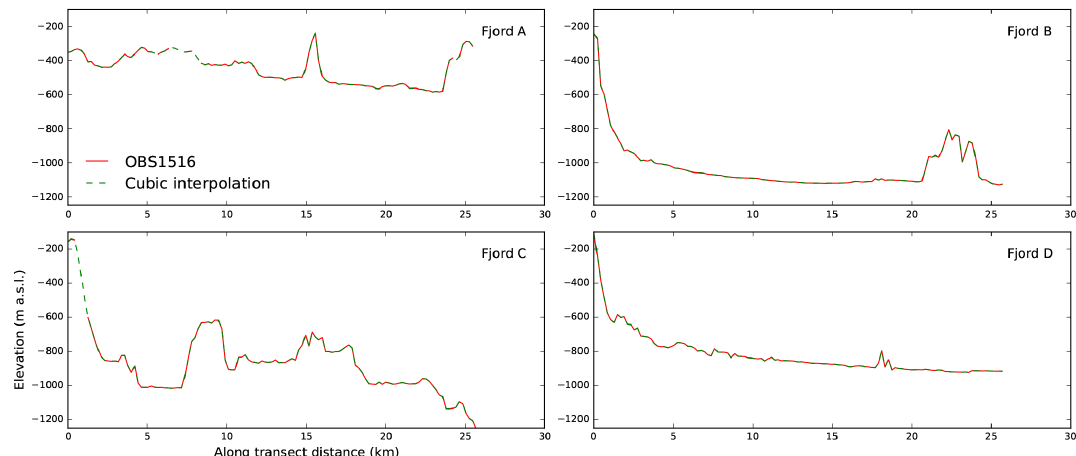
Figure 8. Examples of the along-transect profile of four fjords from the area of interest depicted and labelled in Fig. 7a and b respectively. Along-transect distance starts at the head of each fjord and extends to the fjord mouth.